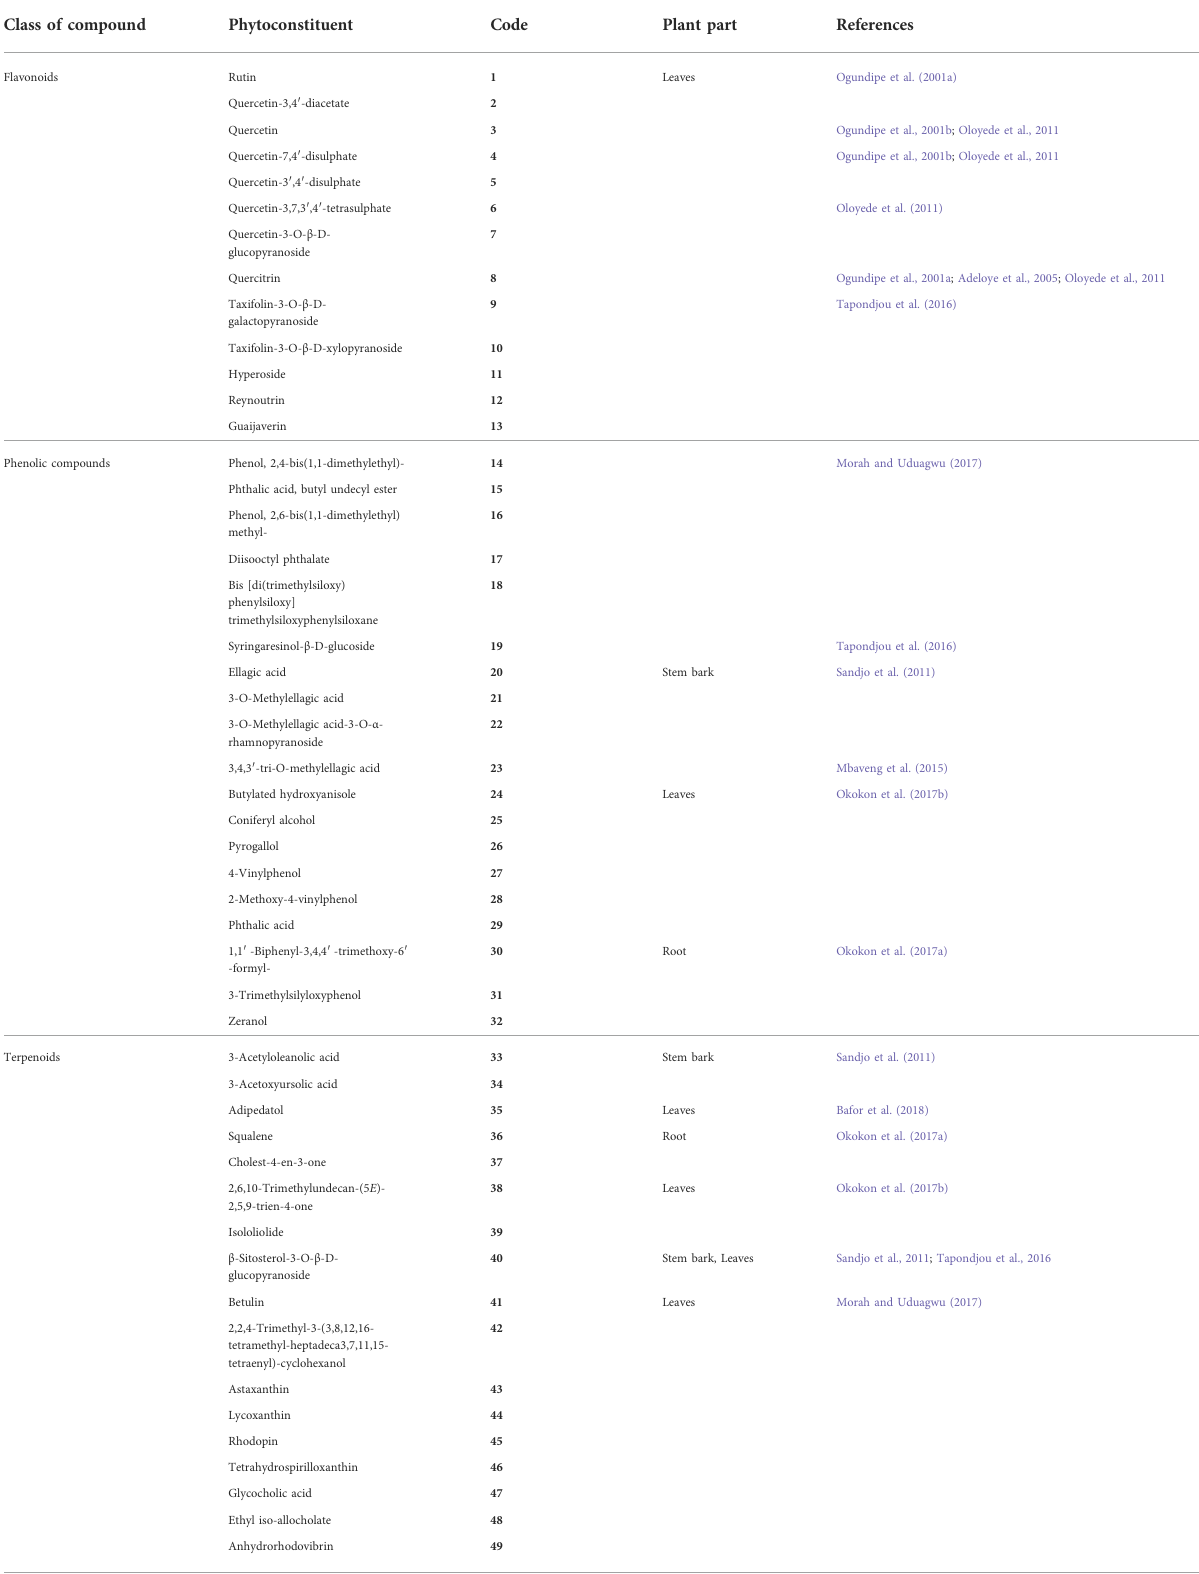
TABLE 2 Phytoconstituents isolated from A. laxi fl ora